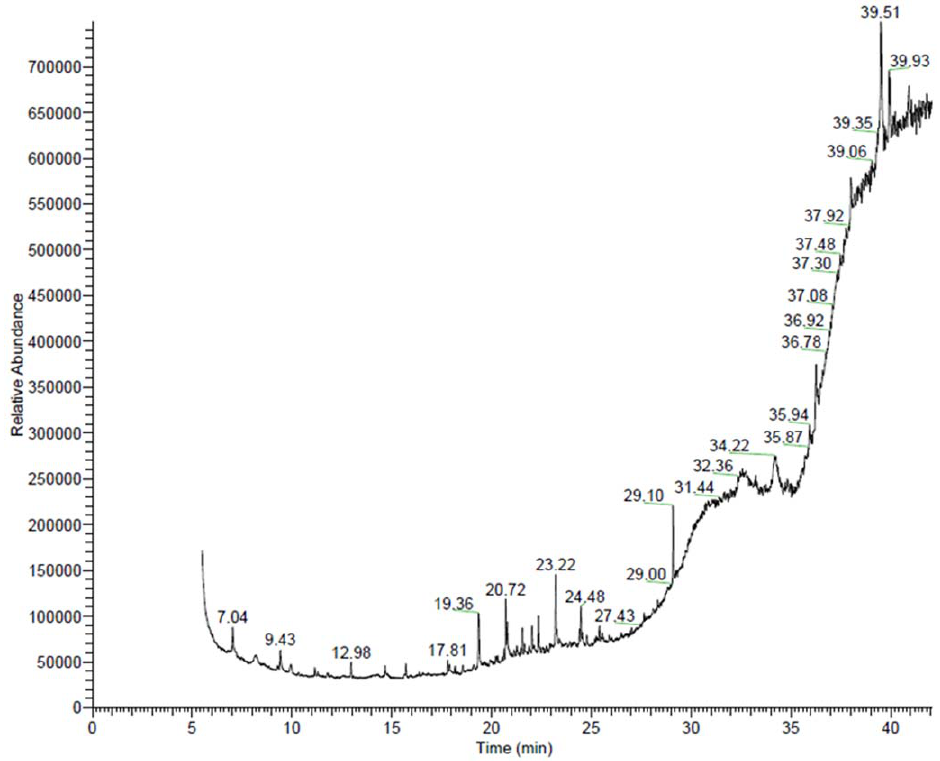
Figure 6. GC/MS chromatogram of 60% ethanol root extract of R.imbricata .